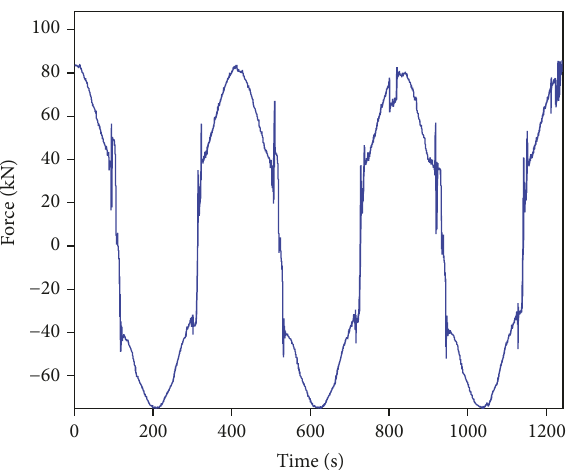
Figure 11: Time-history curve of the damping